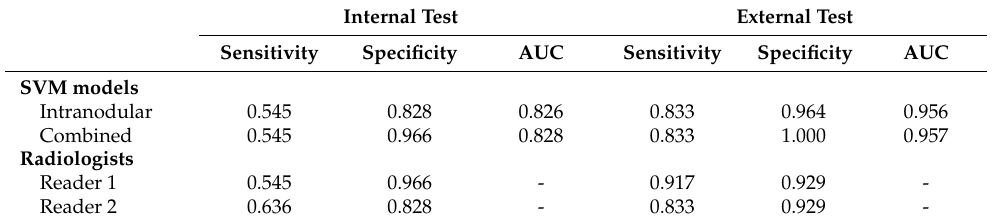
Table 3. Diagnostic performance of the radiomics SVM models and radiologist